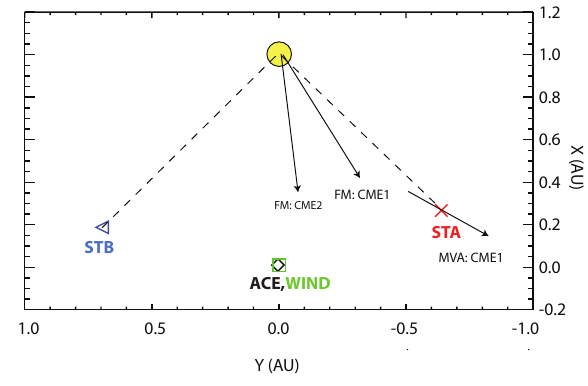
Fig. 2. STEREO/Wind/ACE positions on 2 November 2008. STA and STB were separated by 82 . 5 ◦ in longitude. Two of the ar- rows indicate the direction of propagation for CME1 and CME2 obtained from the forward modelling (FM), and one arrow the lon- gitude angle of the flux rope axis from the minimum variance analy- sis. See Sect. 3.1 for details about the forward modelling technique and Sect. 3.2 for details about the minimum variance analysis.